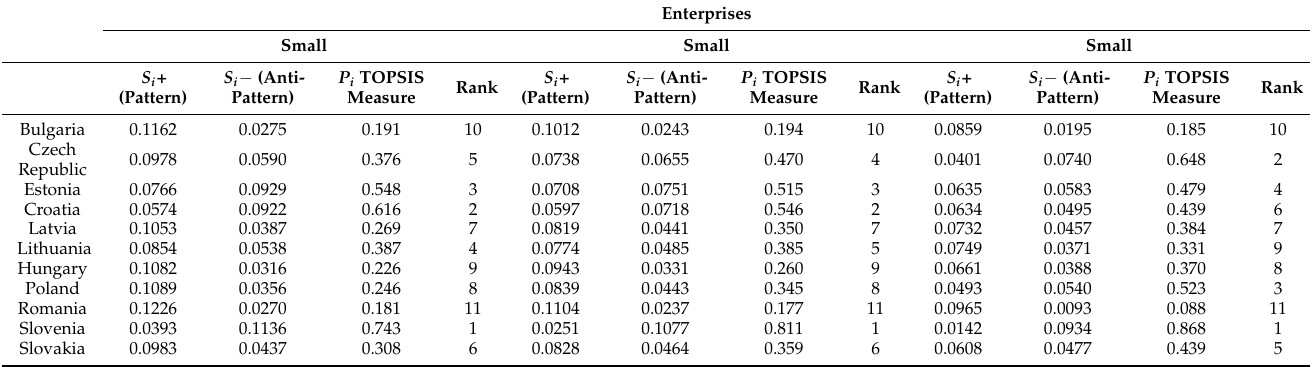
Table 8. Distance of individual CEE countries from the pattern and anti-pattern together with the TOPSIS measure for the level of digitalization of individual groups of enterprises. Enterprises Small